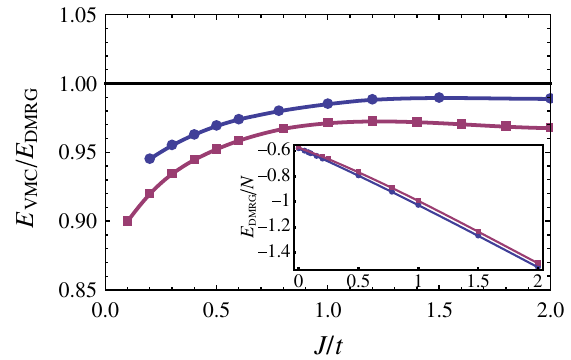
FIG. 10. The lowest ground-state energy of projected d þ id variational wave function, obtained by VMC calculations, is shown as a fraction of the DMRG ground-state energy on the same sample. Blue line is for the 24-site sample, red line is for 32- site sample. Inset: DMRG energy per site of 24-site (blue line) and 32-site (red line)